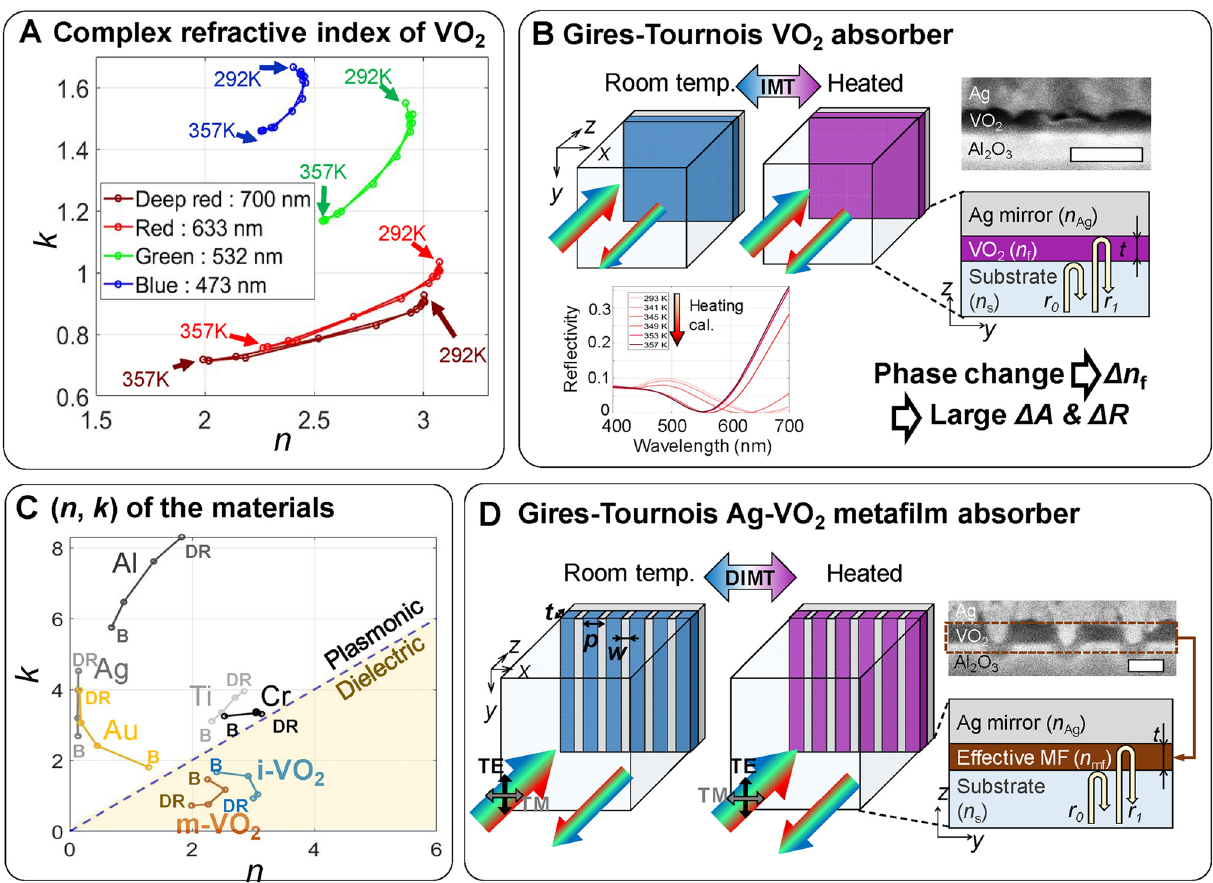
Figure 1: Concept of dynamically tunable phase-change VO 2 meta fi lm absorber. (A) Measured thermally driven cyclic evolutions of ( n , k ) coordinates of VO 2 at the representative blue (473 nm), green (532 nm), red (633 nm), anddeepred(700nm)colors.(B)Schematicillustration,cross-sectionalscanningelectronmicroscopy(SEM)imageofthesapphiresubstrate- VO 2 -AgGires-Tournoisabsorber( t =40nm),andcalculatedresultsoftunablenear-unityabsorptionspectraoftheabsorberduringheating.(C) Complex refractive index map for various materials and VO 2 at the representative four visible wavelengths (B: blue (473 nm), DR: deep red (700 nm)). (D) Schematic description of phase-change meta fi lm based dynamic Gires-Tournois absorber. SEM image shows cross-sectional image of the fabricated dynamic Gires-Tournois meta fi lm absorber with Ag fi lling factor about 0.2. The scale bars in SEM images of (B) and (D) denote 100